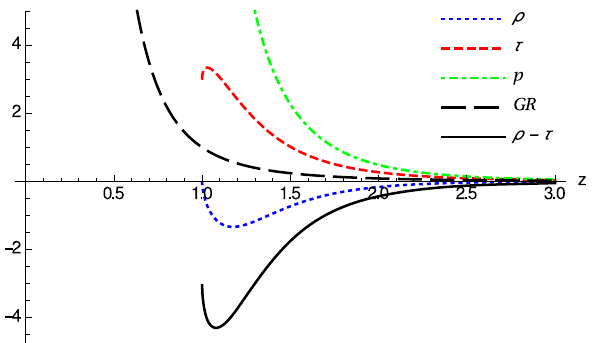
Fig. 7 Same notation and curves as in Fig. 2, now for the f ( R ) gravity case with α = 3 / 4 and parameters δ 2 = 4 δ 1 and δ 1 = 10, for which no horizons are present. Note that the NEC is violated as lim x → 0 ( ˜ ρ − ˜ τ) < 0 (solid black) around the wormhole throat z = 1. Note that though ˜ ρ < 0 near the throat, far away it becomes positive recovering the GR